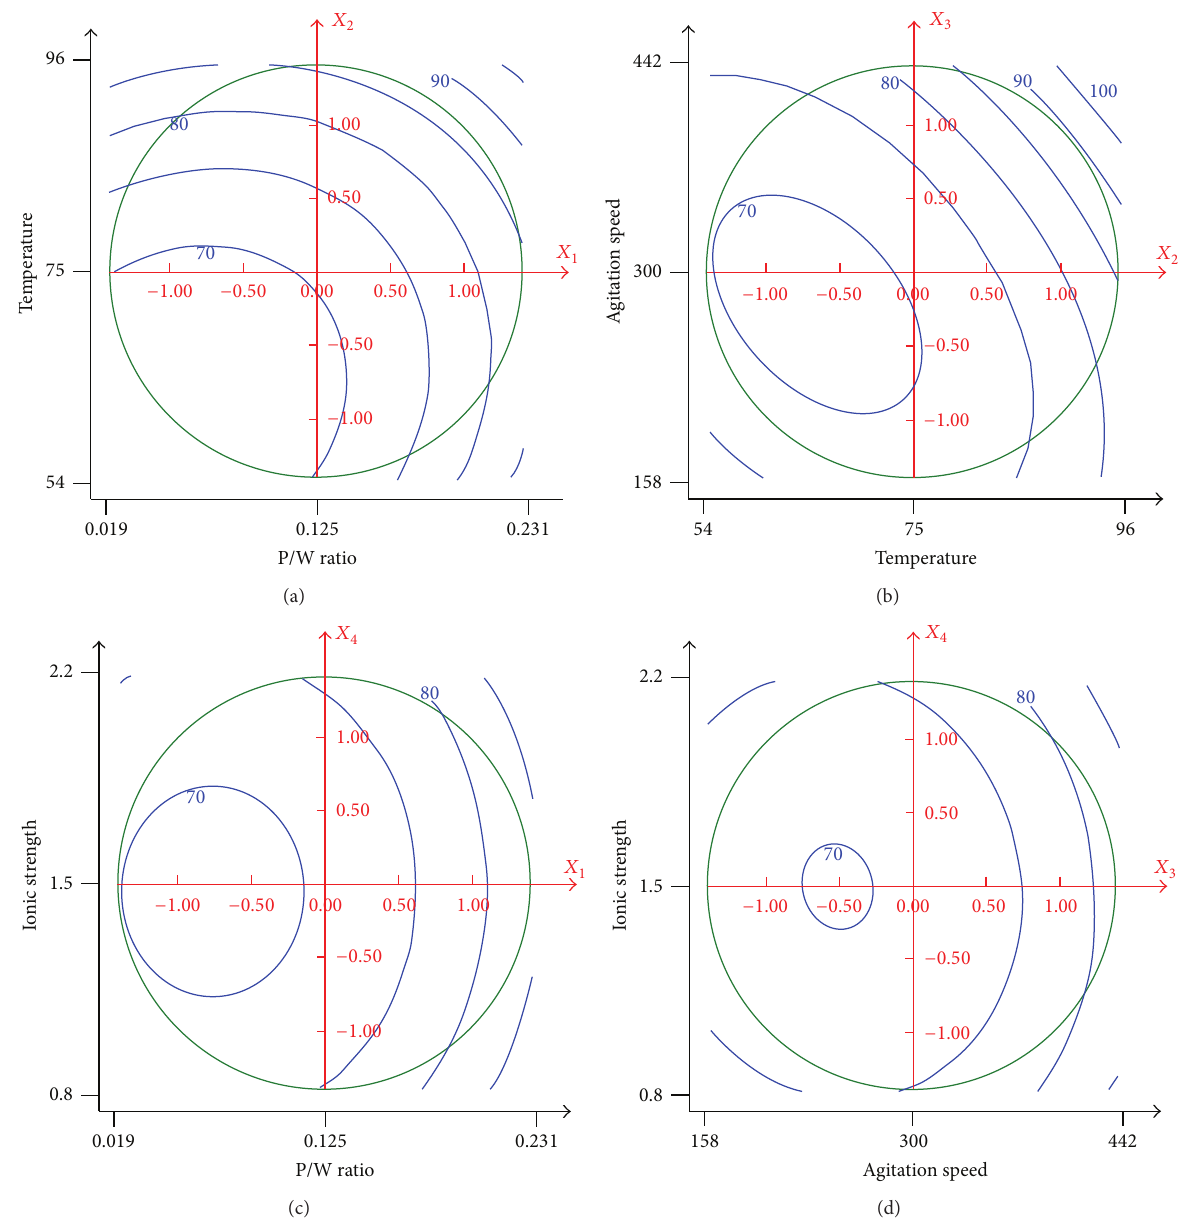
Figure 3: Contour plots illustrating the effect of (a) temperature and P/W ratio at constant agitation speed (300 rpm) and ionic strength (1.5g/L), (b) temperature and agitation speed at constant P/W ratio (0.125) and ionic strength (1.5 g/L), (c) ionic strength and P/W ratio at constant agitation speed (300rpm) and temperature (75 ∘ C), and (d) ionic strength and agitation speed at constant P/W ratio (0.125) and temperature (75 ∘ C) on insoluble fibres yield extracted from dried Agave leaves’ powder.